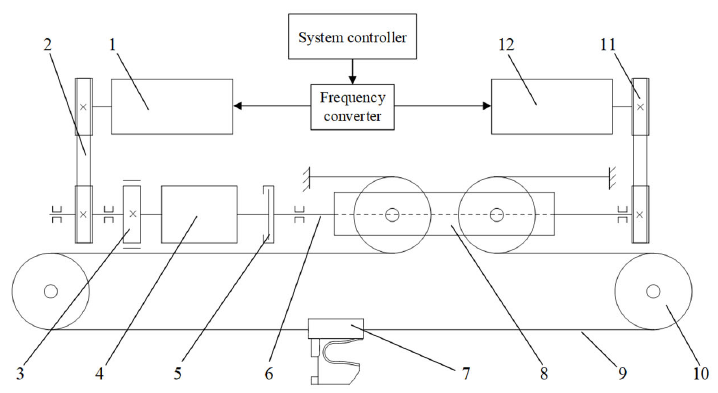
Figure 5. ERSD transmission system schematic diagram. The code names have the following mean ‐